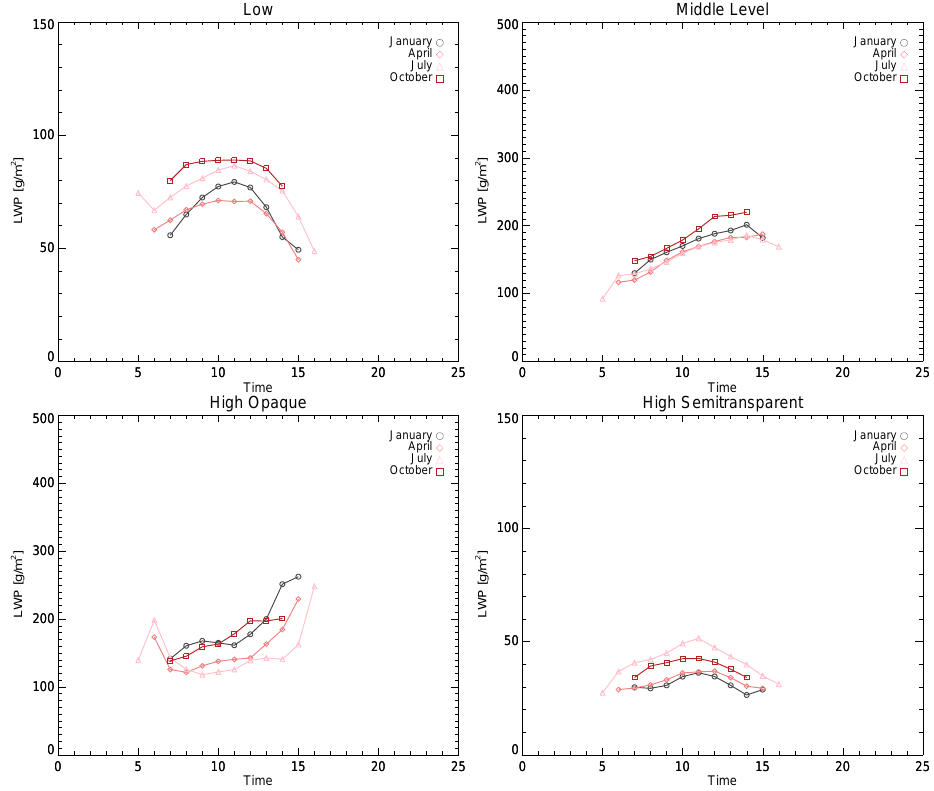
Fig. 12. Average diurnal cycle of LWP from 4 months in 2009 for the Northern Hemisphere in the MSG disc; upper left: low clouds; upper right, middle level clouds; lower left: high opaque clouds and lower right: high semi-transparent clouds. Cloud-free pixels were not averaged.